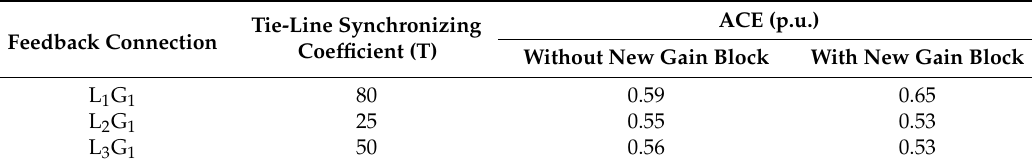
Table 1. Comparison of the effect of electrical proximity introduced through a gain block on ACE for different feedback